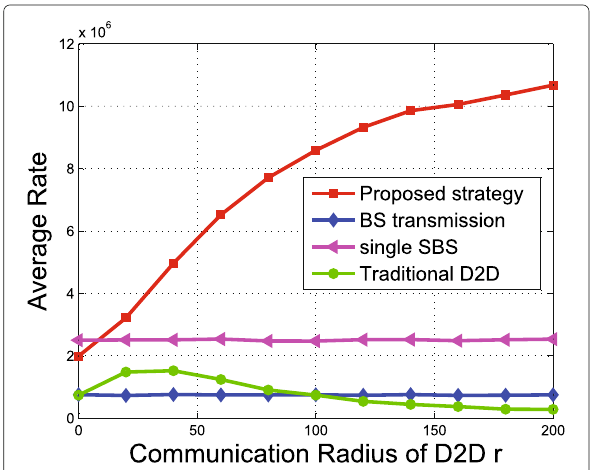
Fig. 9 The relationship between the non-outage probability of BS and the number of requesting users. This fuigure shows the comparison of the non-outage probability between the reference [7] and the proposed system through Monte Carlo simulation